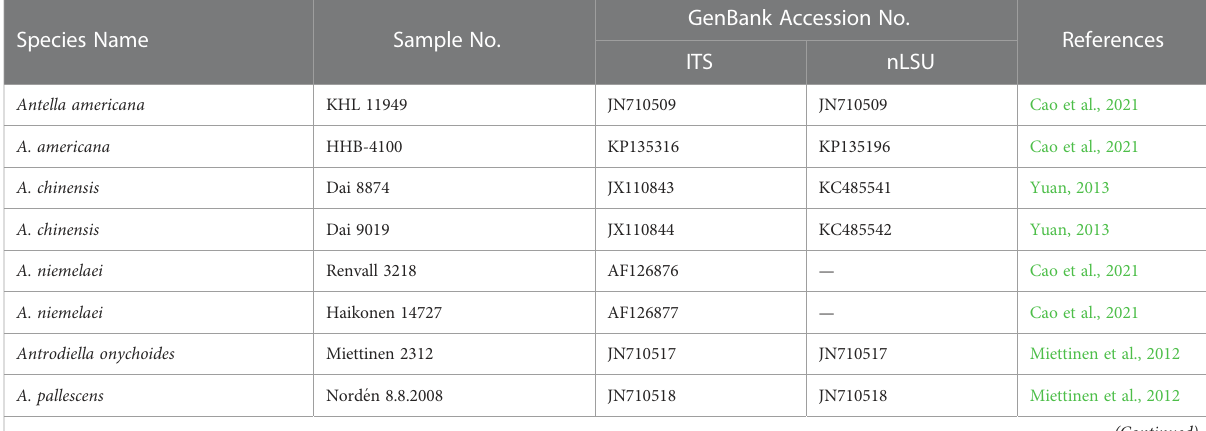
TABLE 2 List of species, specimens and GenBank accession numbers of sequences used in this study. * is shown type material, holotype.